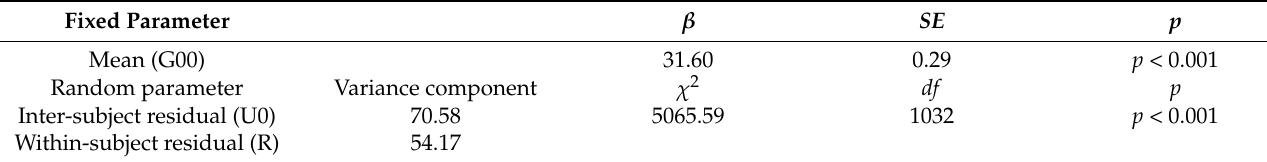
Table 3. Analysis results of the null